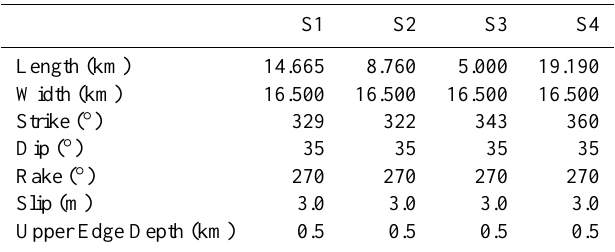
Table 3. Seismic parameters for the tsunamigenic earthquake source 1693 E proposed by Argnani and Bonazzi (2005). S1 and S4 are the extreme segments from north to